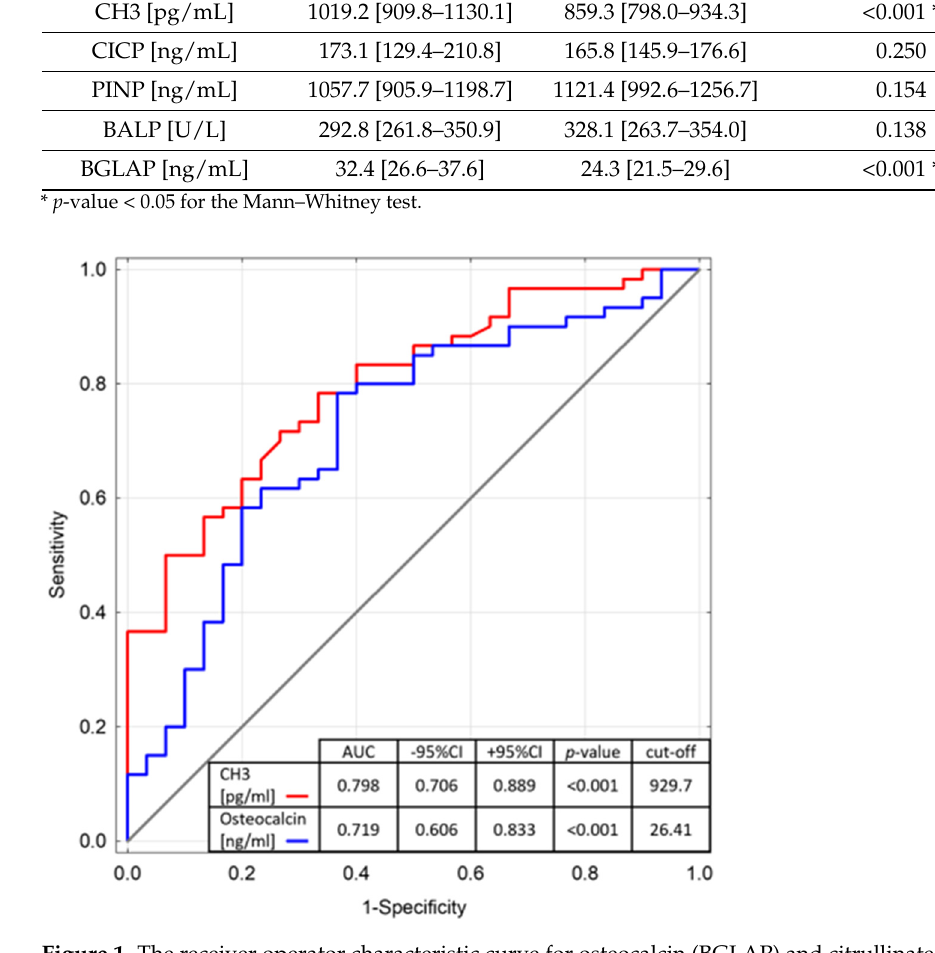
Figure 1. The receiver operator characteristic curve for osteocalcin (BGLAP) and citrullinated histone (CH3) levels for classification of patients with and without haemophilia (Youden’s Index). AUC—the area under the ROC curve; CI—confidence interval.